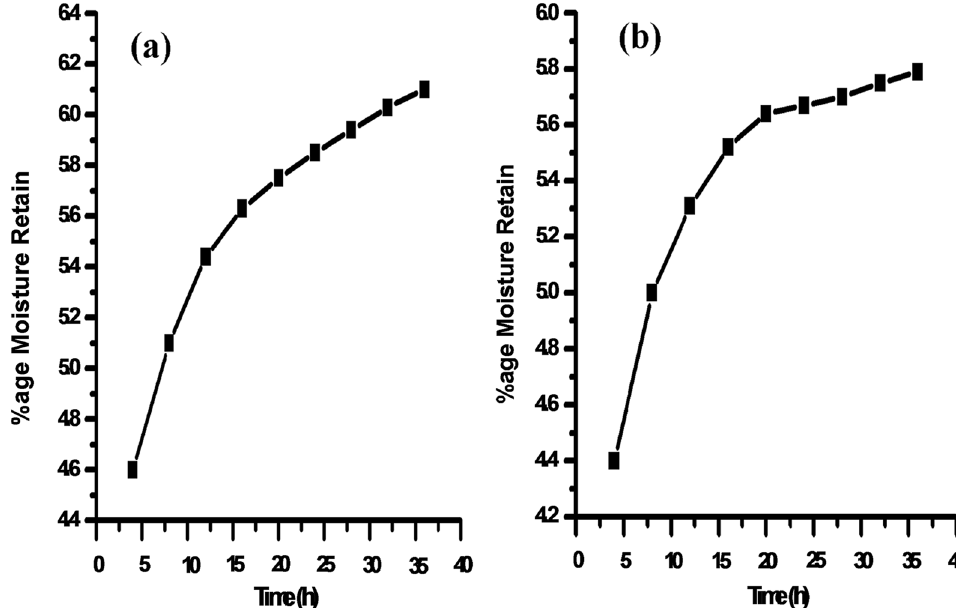
Fig. 11 a, b Water retention capacity of a clay soil and b sandy loam soil using